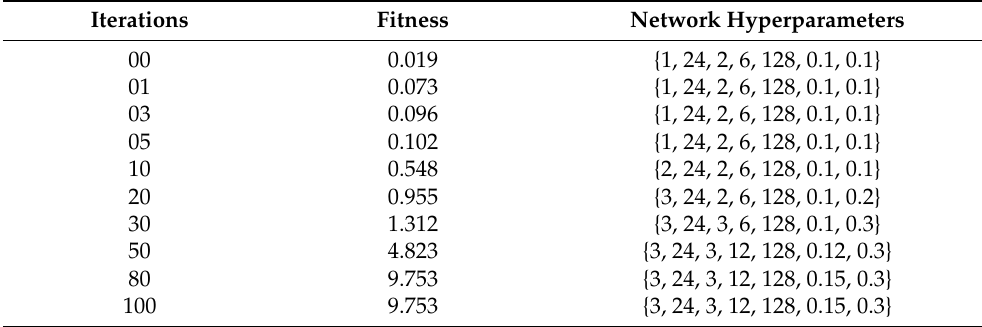
Table 11. The variations of fitness and corresponding network hyperparameters in dataset 1.